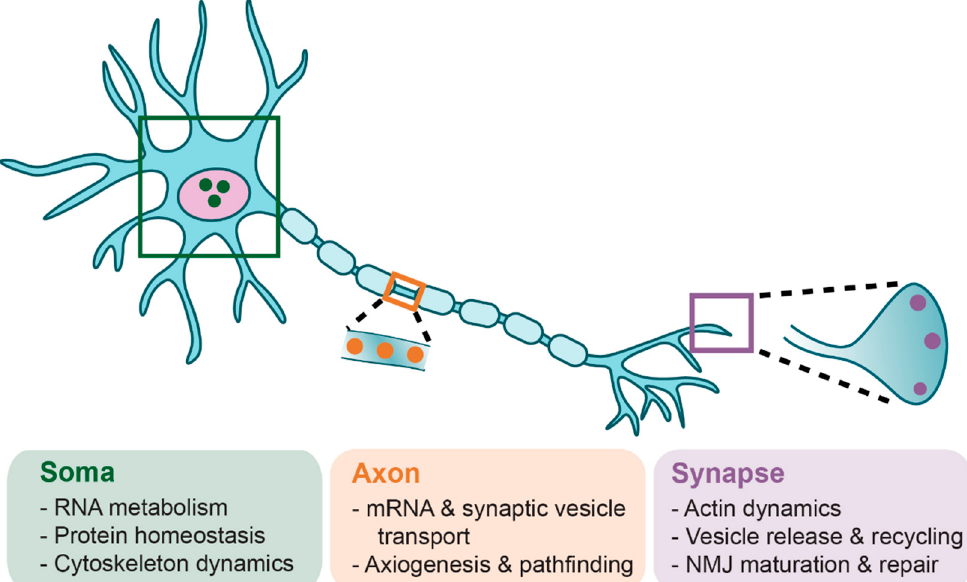
Figure 2. General cellular functions of SMN in motoneurons. SMN has several proposed functions in the motoneuron, though which roles are associated with which specific pathologies are unclear. SMN functions in RNA metabolism, protein homeostasis, and cytoskeleton dynamics. SMN plays additional roles in axonal transport of mRNA and synaptic vesicles, axiogenesis, and axon pathfinding. At the neuromuscular synapse, SMN is involved in actin dynamics, vesicle release and recycling, and neuromuscular junction (NMJ) maturation and repair. These cellular functions of SMN have been thoroughly discussed elsewhere [52,56,70–74].